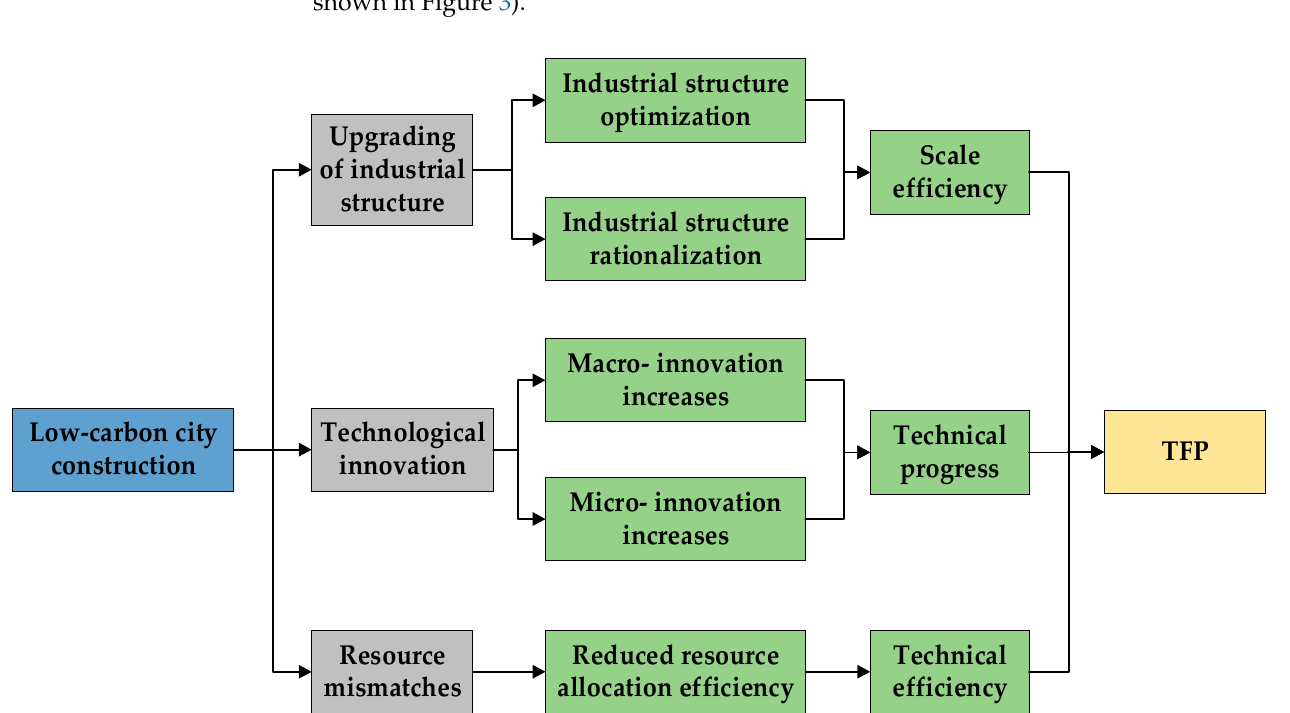
Figure 3. Mechanism of effects of low-carbon city construction (LCC) on the total factor productivity (TFP).